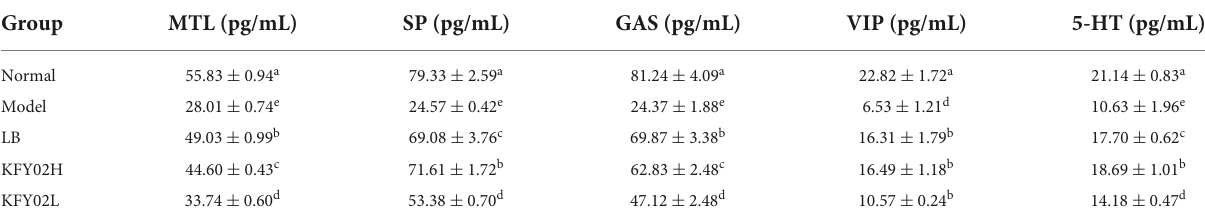
TABLE 3 Serum levels of MTL, SP, GAS, VIP, and 5-HT in